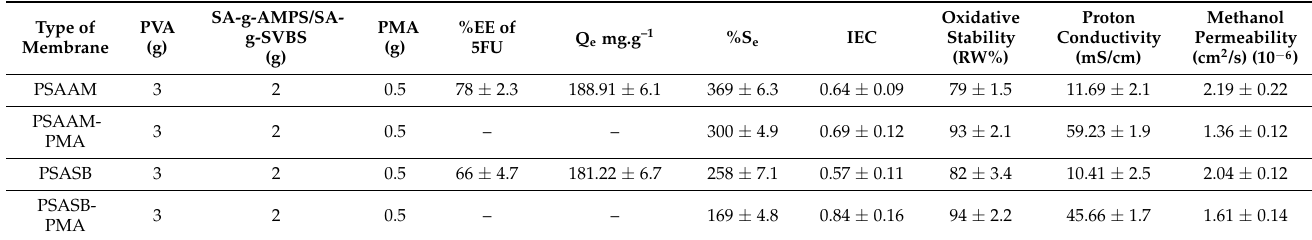
Table 1. Composition, %S e , IEC, proton conductivity and methanol permeability of various PEMs.